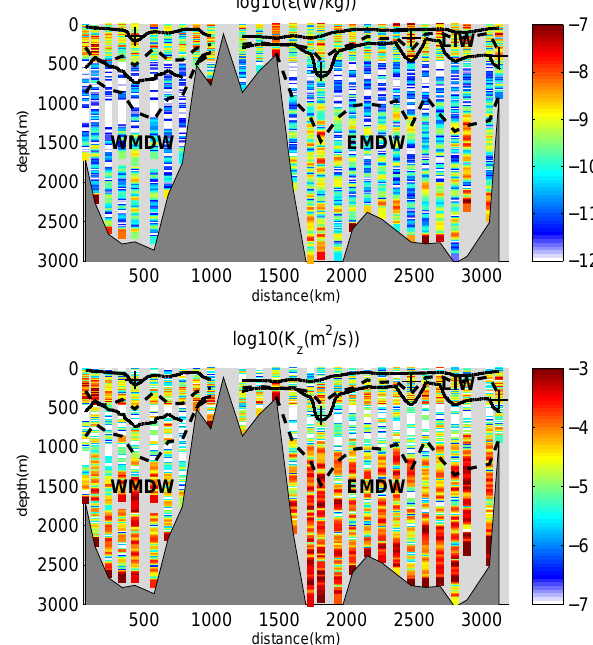
Fig. 14. Parameterized dissipation rate (upper panel) and param- Figure 14: parameterized dissipation rate (upper panel) and parameterized diapycnal di(cid:27)usivity eterized diapycnal diffusivity (lower panel) along the BOUM tran- (lower panel) along the BOUM transect. The abscissae x is expressed as the distance along the sect. The abscissae x is expressed as the distance along the transect transect from the (cid:28)st station in the Rhone river mouth (not represented). Black cross indicate approximate positions of the base of eddy A, B, C and Ierapetra eddy. Black lines represent from the first station in the Rhone river mouth (not represented). isopycnal 28.5 and 29.1 kg/m − 3 , black dashed lines represent the core of the LIW, and the limits Black cross indicate approximate positions of the base of eddy A, of EDMW and WDMW B, C and Ierapetra eddy. Black lines represent isopycnal 28.5 and 29.1kgm − 3 , black dashed lines represent the core of the LIW, and the limits of EDMW and